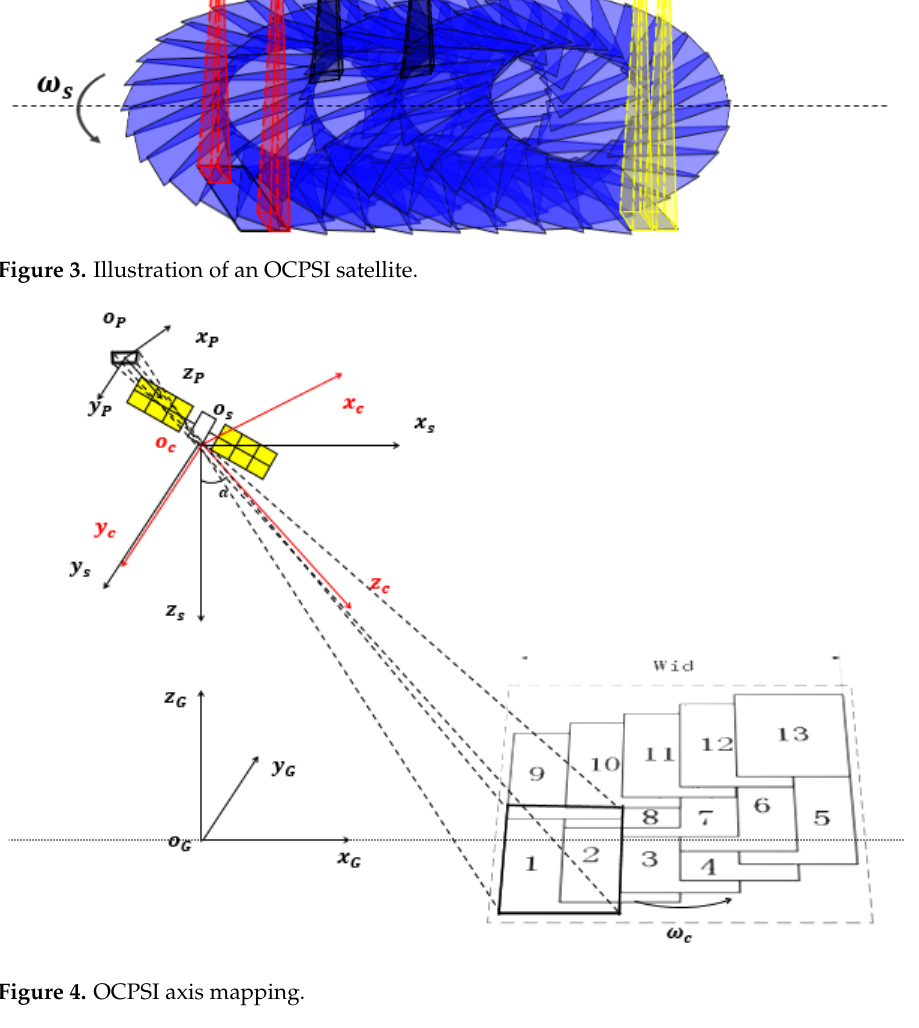
Figure 4. OCPSI axis mapping.